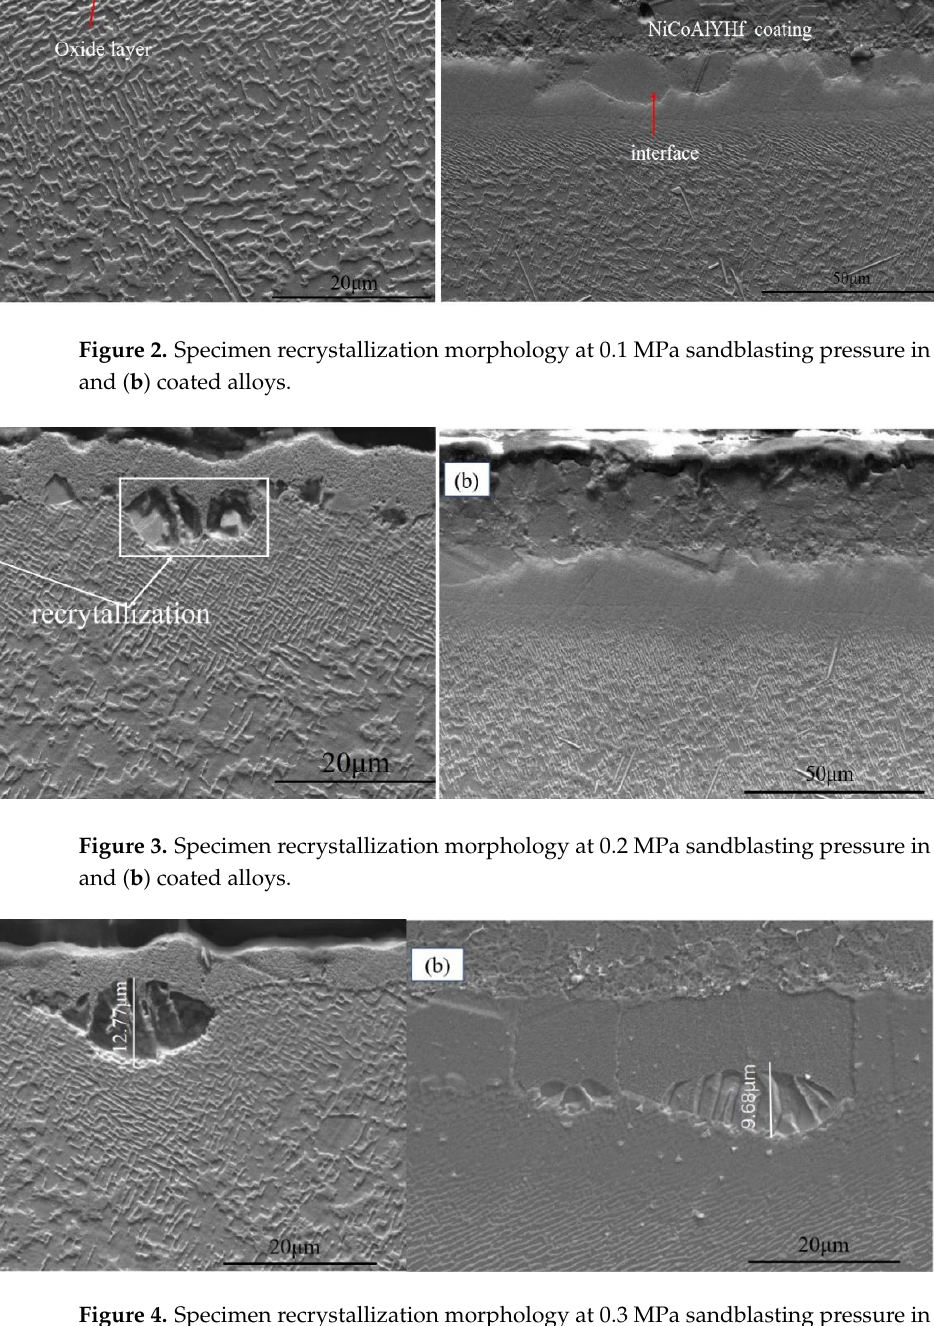
Figure 5. Specimen recrystallization morphology at 0.5 MPa sandblasting pressure in ( a ) uncoated and ( b ) coated alloys .